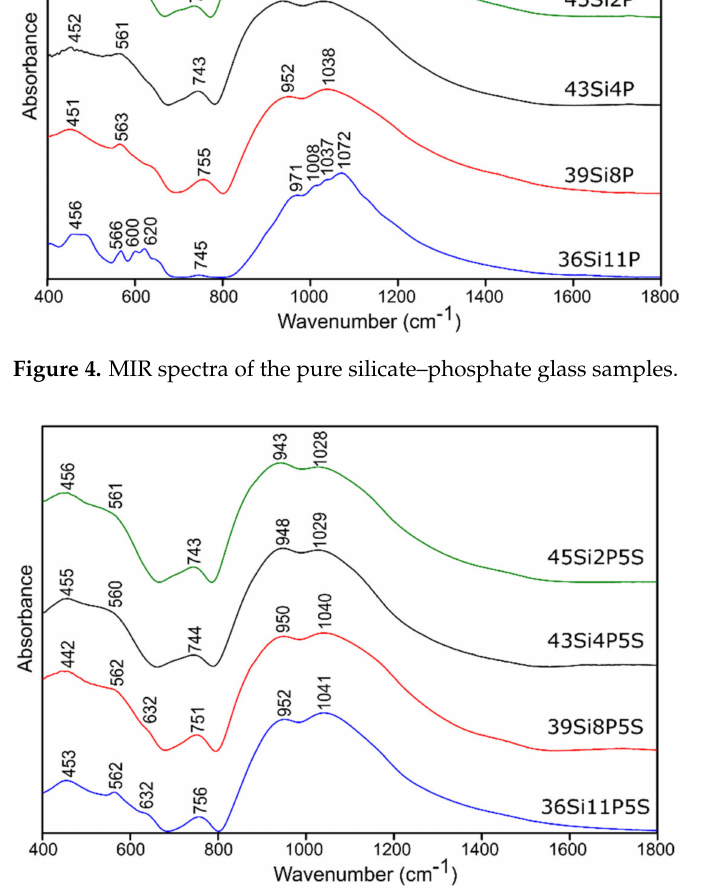
Figure 5. MIR spectra of the sulfur-doped silicate–phosphate glass